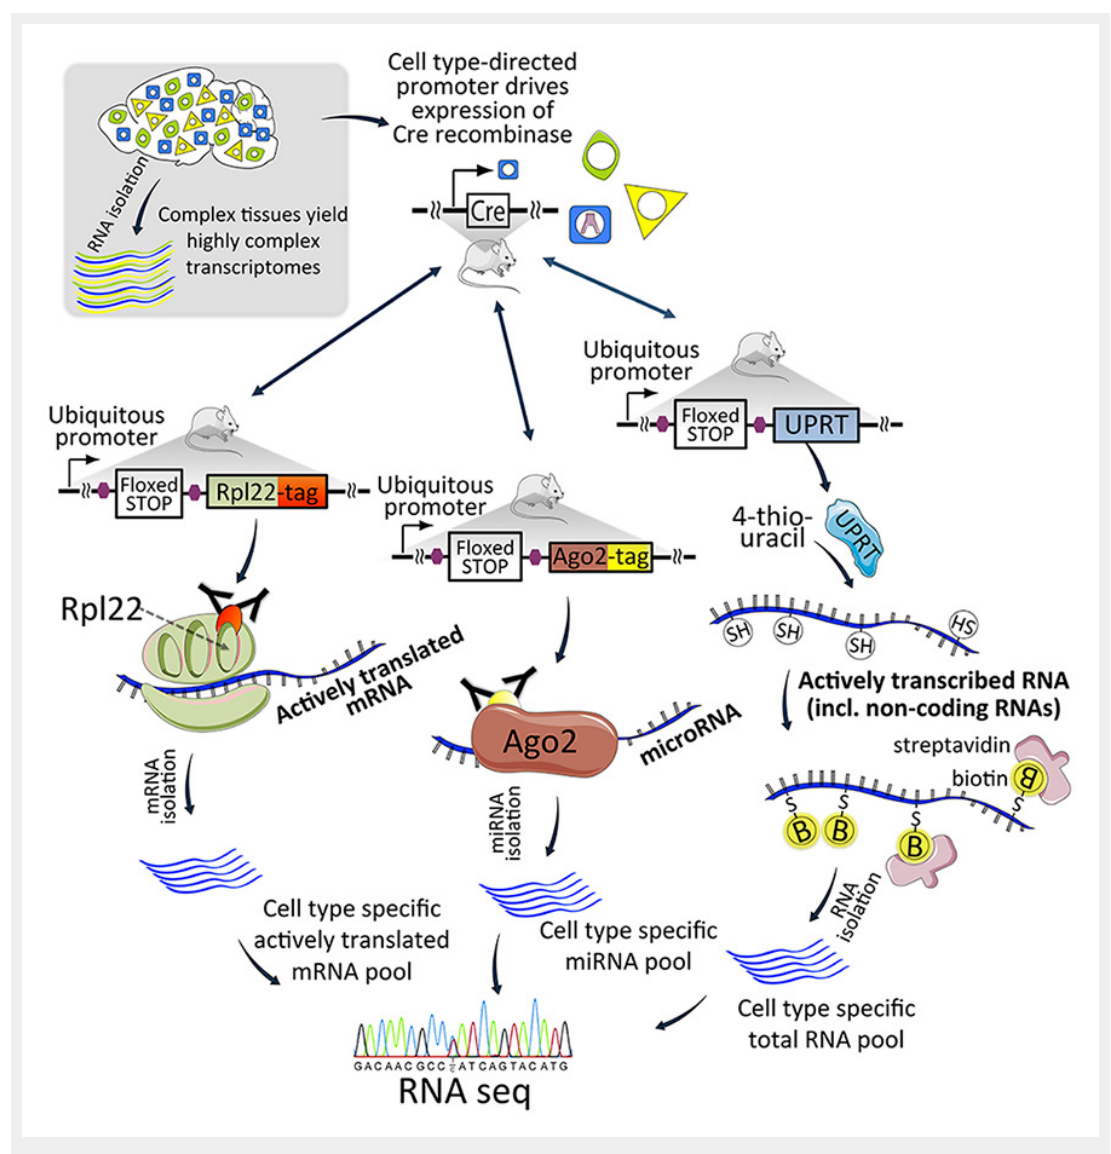
Figure 4 Transgenic techniques for cell type-specific RNA capture. A mouse expressing Cre recombinase is bred with a mouse encoding transgenes for RNA capture components. Each transgene is activated by Cre to drive cell type-specificity. The Rpl22 (ribosomal protein L22) protein captures ribosomes and ribosome-bound mRNAs during translation (the Ribotag method). The Ago2 protein captures the RISC complex and associated miRNAs. The UPRT enzyme converts 4-thiouracil into a nucleotide that is incorporated into newly transcribed RNA. Ago2 = Argonaute2; miRNA = microRNA; RISC = RNA-induced silencing complex; UPRT = uracil